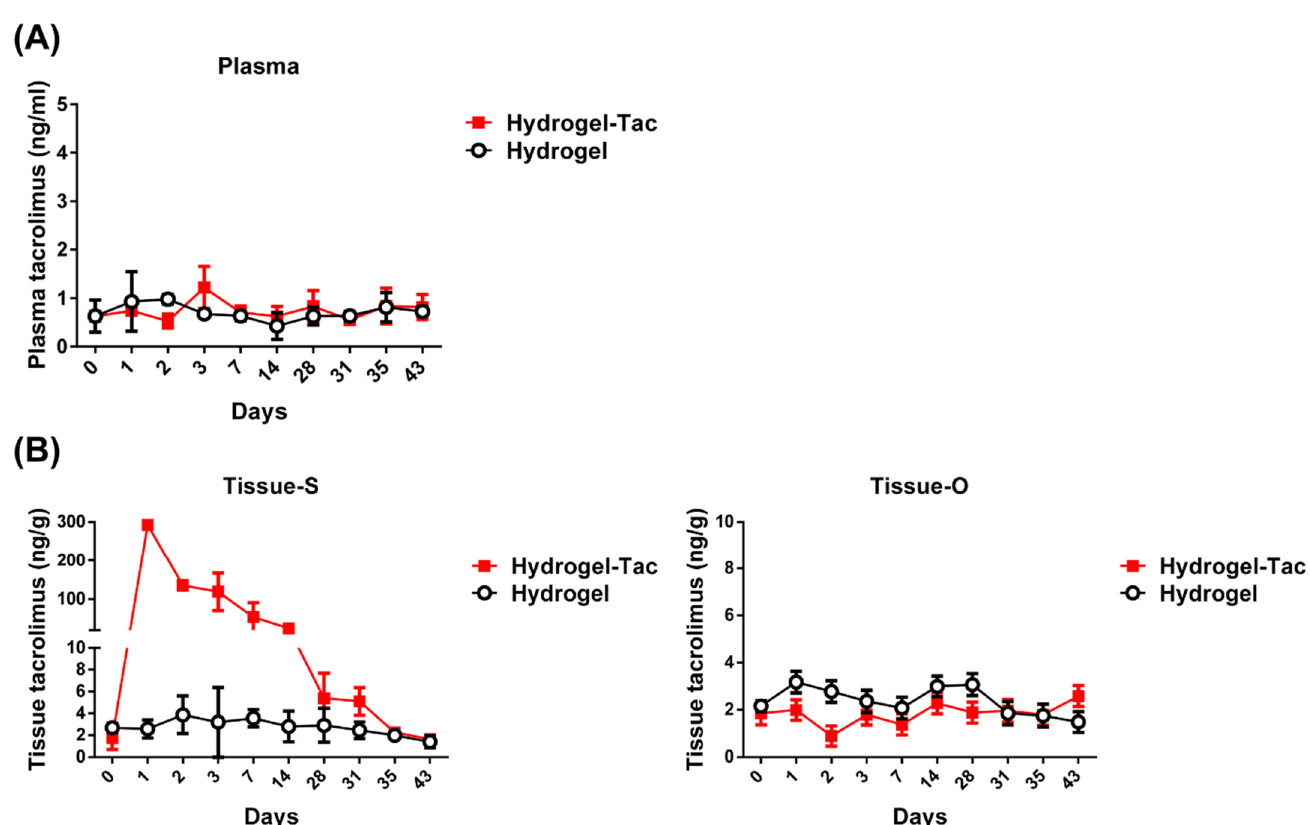
Figure 3. The sustained-release pharmacokinetics of Hydrogel-Tac in the mouse model. 0.1 mL of hydrogel or Hydrogel-Tac was injected into the subcutaneous space of the hindlimb, which was near the transected sciatic nerve. At different time points, plasma and hindlimb muscle tissue (100 mg) were harvested from the mice treated with one subcutaneous injection of 0.1 mL of hydrogel or Hydrogel-Tac (2 mg/mL). 100 mg of muscle tissue was further digested to release tacrolimus and then dissolved in 300 μ L of lysis buffer for the tacrolimus ELISA. ( A ) Tacrolimus concentration (ng/mL) in the blood of the hydrogel-injected mice was detected via tacrolimus ELISA. ( B ) Tacrolimus concentration (ng/g) in the hindlimb tissue of the hydrogel-injected mice was analyzed by tacrolimus ELISA. Tissue-S refers to the right hindlimb muscle and sciatic nerve tissue, which were on the same side as the hydrogel injection. Tissue-O refers to the left hindlimb muscle and sciatic nerve tissue, which were on the side opposite to the hydrogel injection. Day 0 means samples harvested from naïve C57BL/6 mice without any hydrogel injection. Each group had three mice. Mean ± SD was used to represent the statistical data.